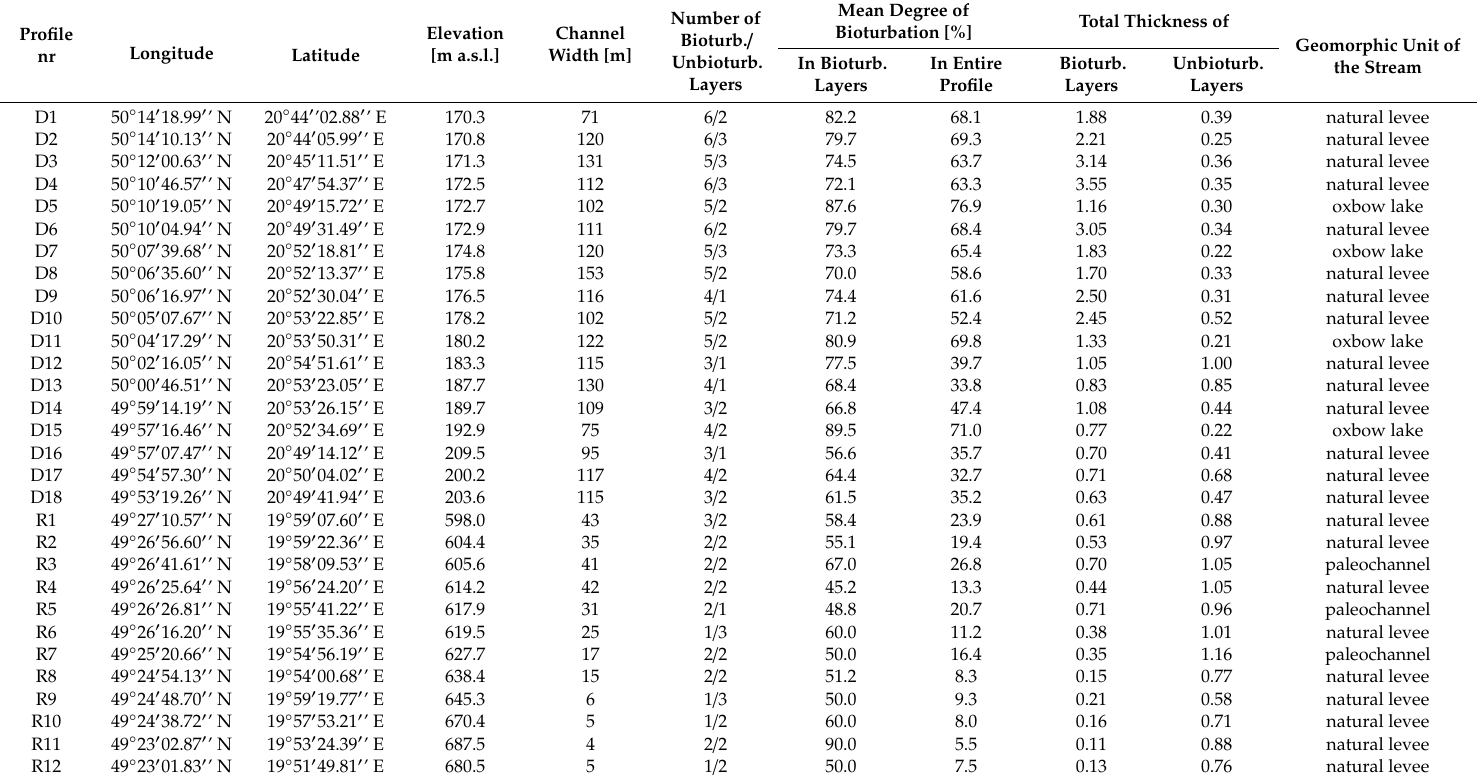
Table 1. General characteristic of the studied vertical profiles in the lower reach of the Dunajec River and in the Rogo´znik